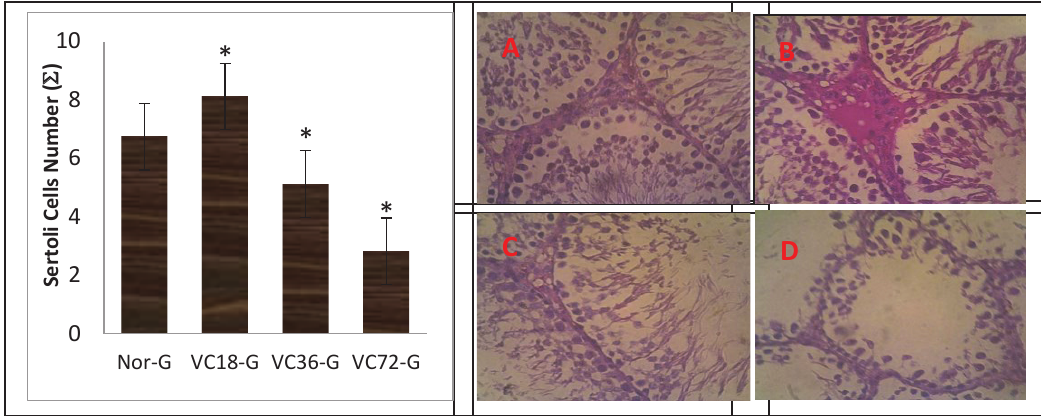
Figure 3. Sertoli Cells Number in each Group. A: Nor-G; B: VC-18-G; C: VC36-G; D: VC72-G. * p < 0.05 Nor-G as a control